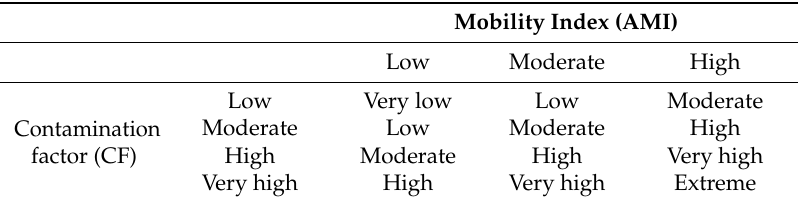
Figure 5. Potential mobilizable arsenic content in acidic medium. Table 2. Environmental risk assessment criteria.